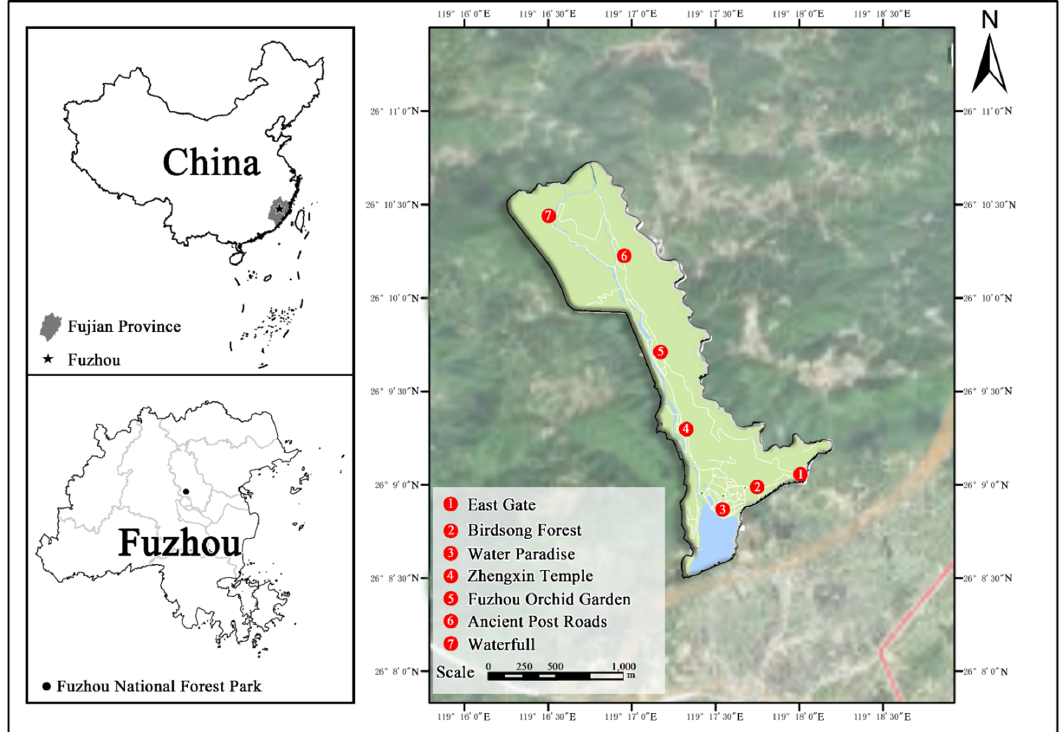
Figure 1. Study Area